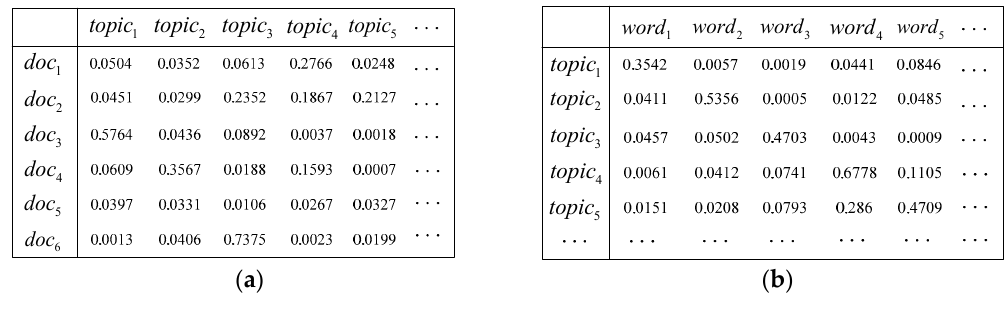
Figure 2. Assuming that there are 6 documents (texts) in a corpus, the ( a ) document—topic distribution and ( b ) topic—word distribution are as depicted.